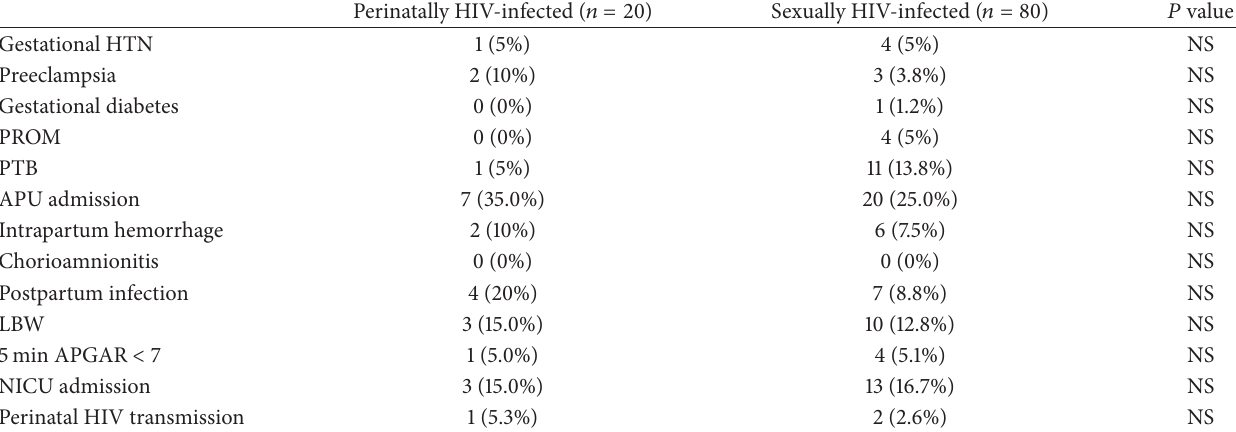
Table 3: Maternal and neonatal complications of perinatally HIV-infected versus sexually HIV-infected parturients. Perinatally HIV-infected ( 𝑛 = 20 ) Sexually HIV-infected ( 𝑛 = 80